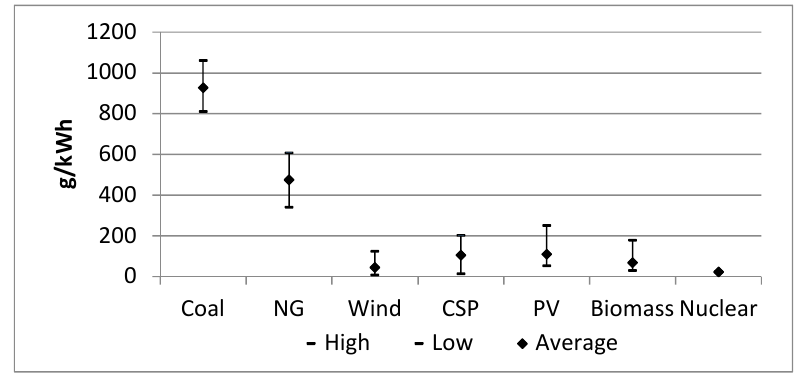
Figure 5. CO 2 emissions from the technologies under assessment [19,40–45,63].